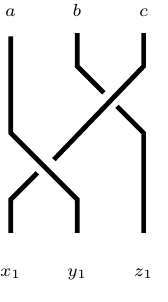
Fig. 3: Propagation of colors down σ 2 σ − 1